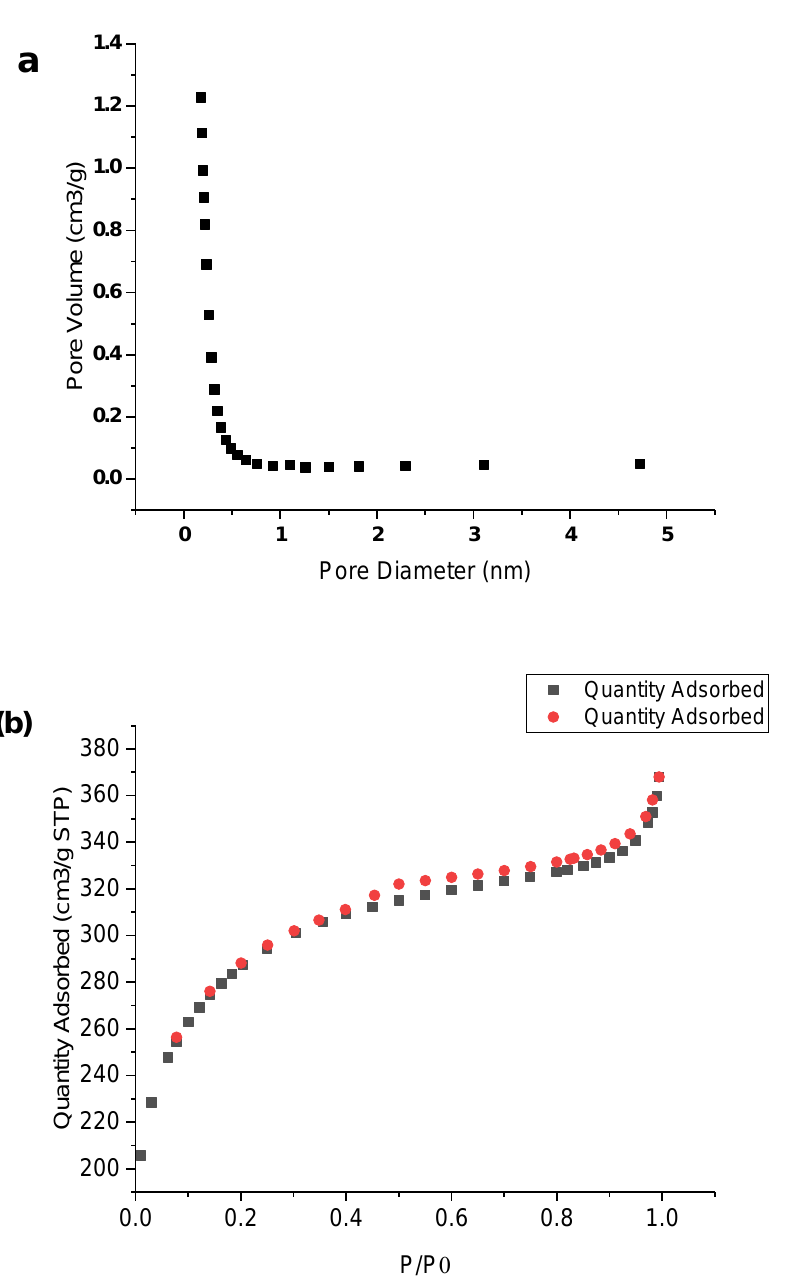
Figure 4. ( a ) BJH pore size distribution curve of CDC; ( b ) N 2 adsorption–desorption isotherm of Figure 4. (a ) BJH pore size distribution curve of CDC; ( b ) N 2 adsorption – desorption isotherm of CDC.